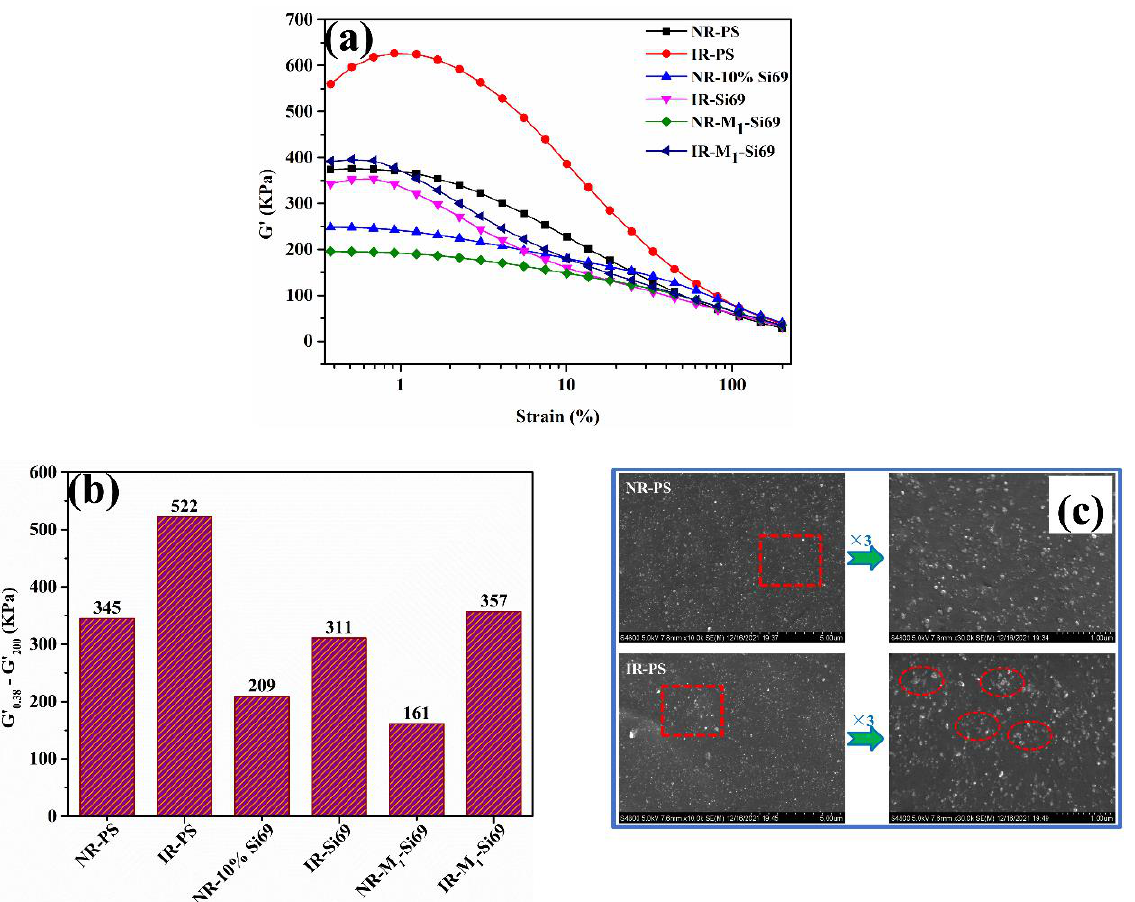
Figure 7. ( a ) Storage modulus versus strain, ( b ) difference of the storage modulus, and ( c ) micromorphology of the rubber nanocomposite.